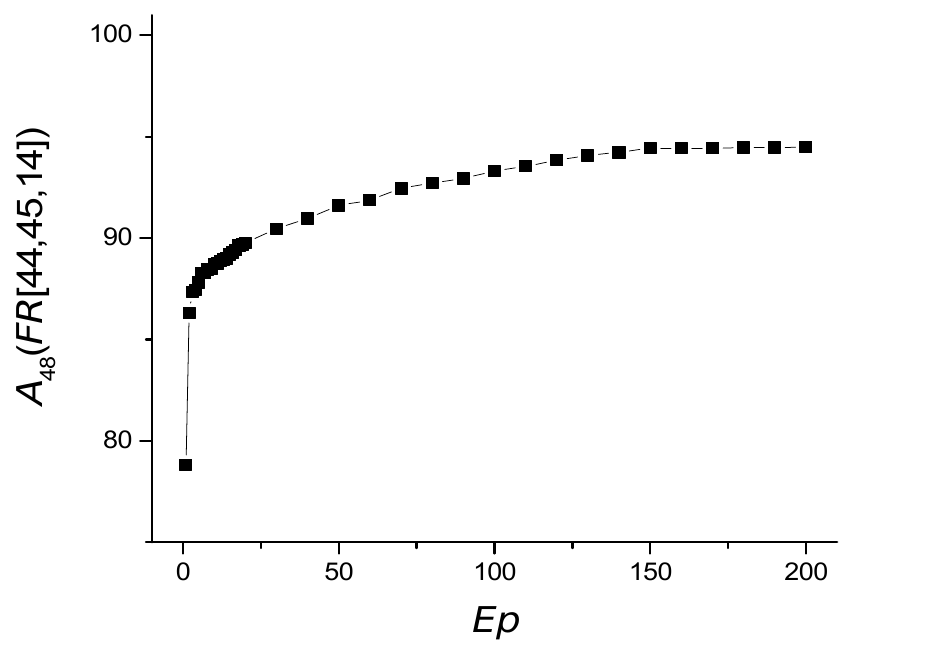
Figure 8. Dependence of A 48 ( FR [14,44,45]) on the number of epochs Ep .